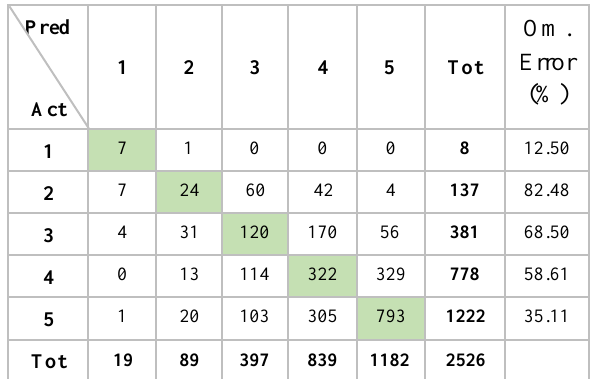
Table 2 - Confusion matrix for functional class based on mean speed.